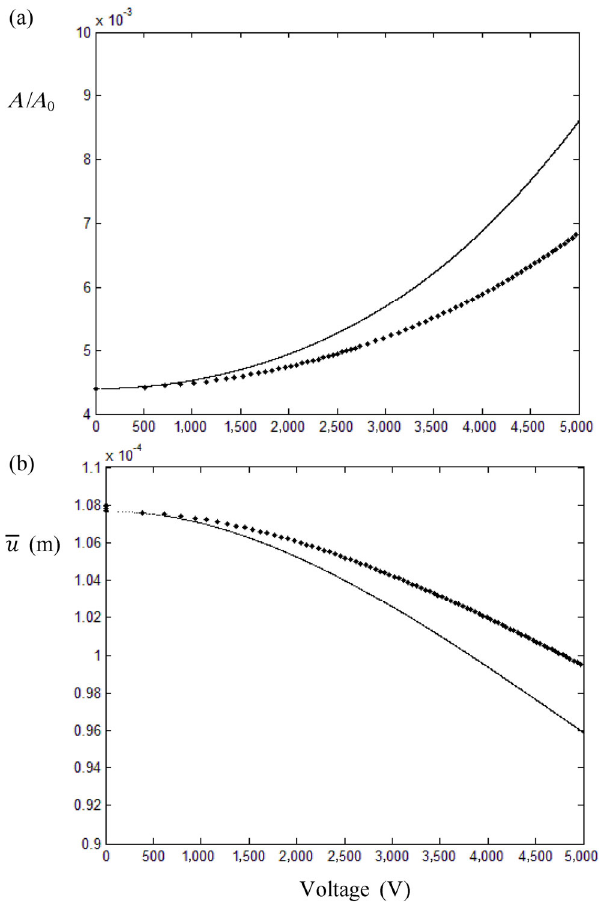
| https://mc03.manuscriptcentral.com/friction